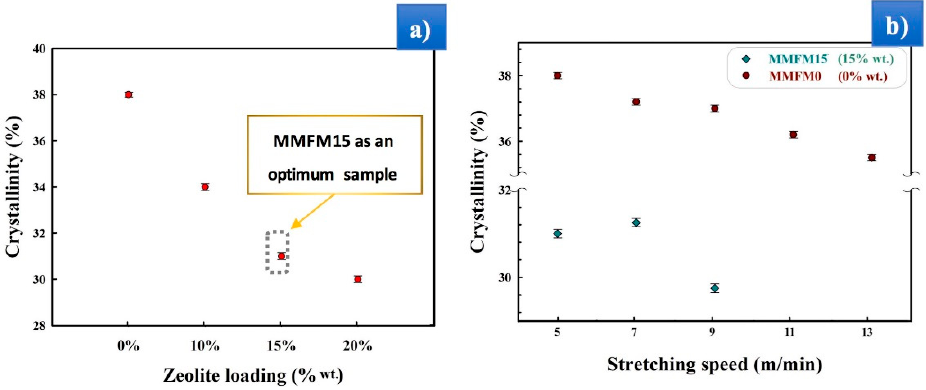
Figure 11. Effect of ( a ) zeolite loading and ( b ) stretching speed on the crystallinity of MMFMs.